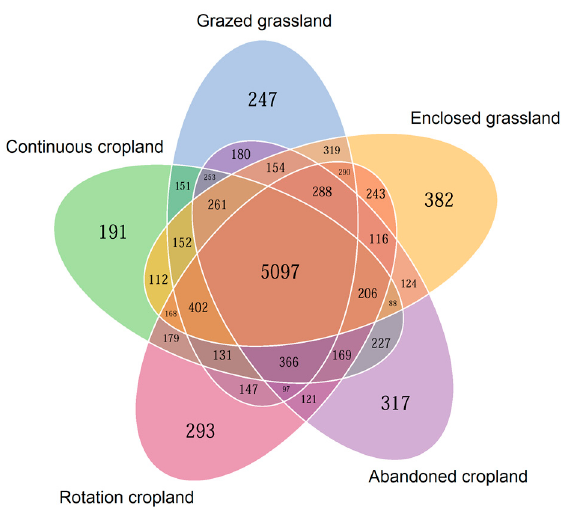
Figure 1. Venn diagrams demonstrating the averaged shared and unique bacterial sequences associ- ated with different land use patterns ( n = 4).